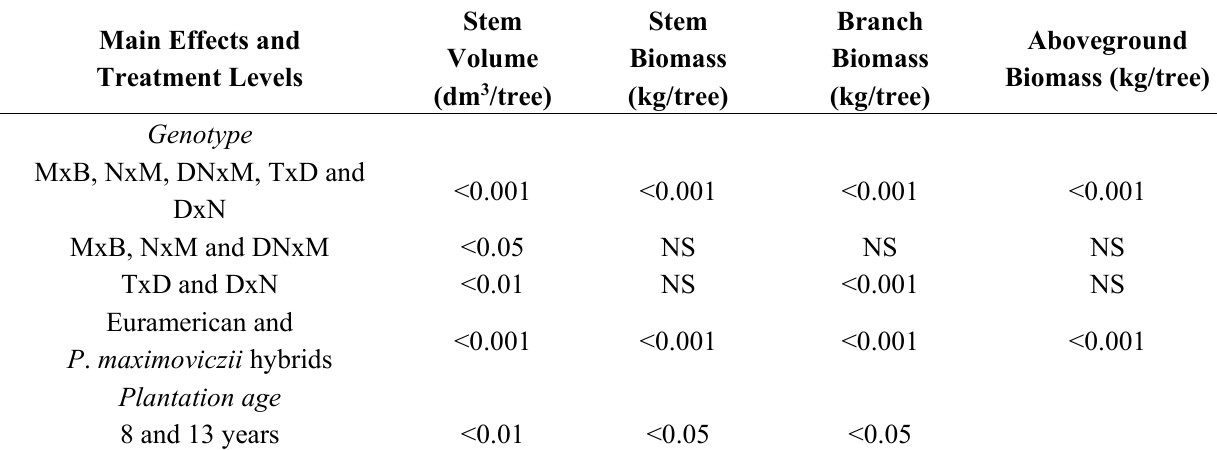
Table 4. Significance level ( p -value) of the main effects for the analysis of covariance (ANCOVA) testing DBH, as a continuous covariate, and genotype or plantation age, as nominal main effects on the different growth variables (stem volume, stem biomass, branch biomass and aboveground woody biomass). The covariate was always significant at p < 0.001. The Genotype effect was tested on 13 year-old poplar data, while the Plantation age effect was tested on the data set combining data from 8 and 13 year-old poplars. Data were log transformed prior to analysis; NS = non